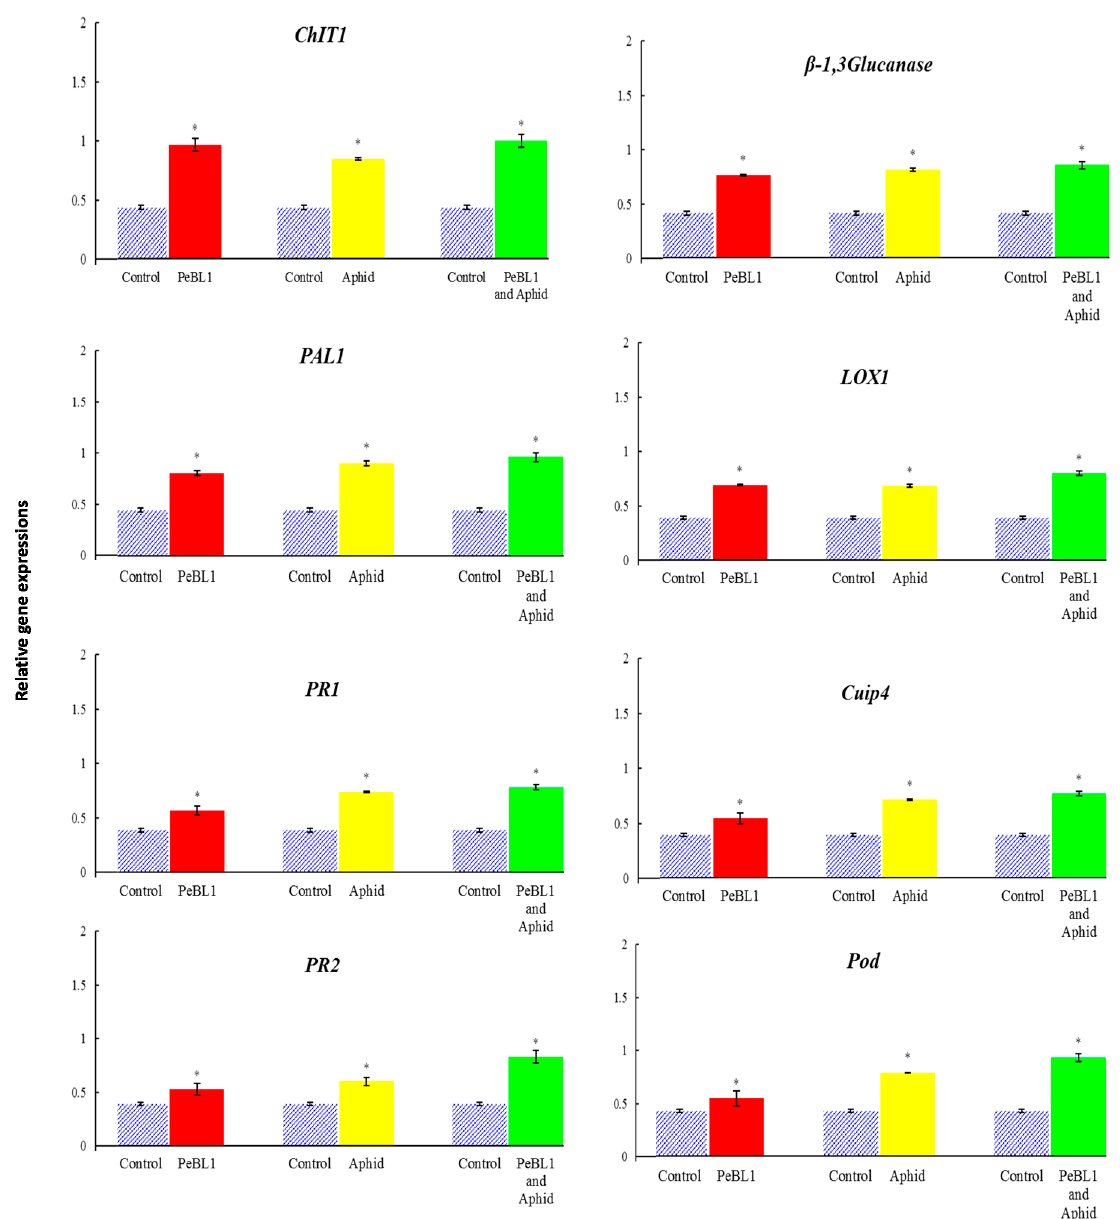
Figure 8. Relative expression of plant defense from the JA, SA, and ET pathway genes found after treatment with the PeBL1 elicitor, PeBL1 and aphid, and aphid infestation alone. For each gene, an asterisk on the bar shows a significant difference from the buffer control, as found by Student’s t -test ( p < 0.05). Table 4. Log 2 of fold change expressions all test genes involved in the JA, SA, and ET pathways after the PeBL1 elicitor application, PeBL1 and aphid, and aphid infestation alone. Log 2 Fc (Treated/Untreated) PeBL1 Aphid PeBL1 and Aphid